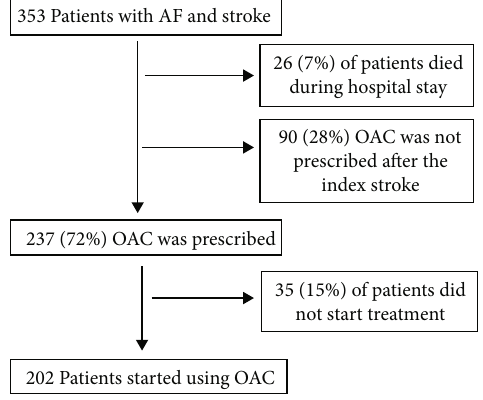
Figure 1: Patient